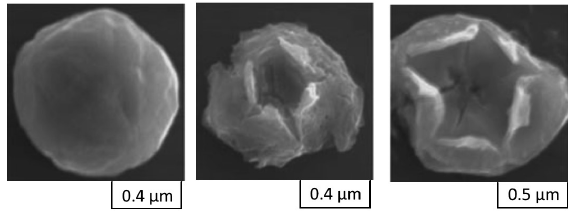
Figure 4: Cu micro/nanoparticle of pentagonal symmetry with an interior void revealed after chemical etching. For details, the reader can consult [10, 24] and references quoted therein.